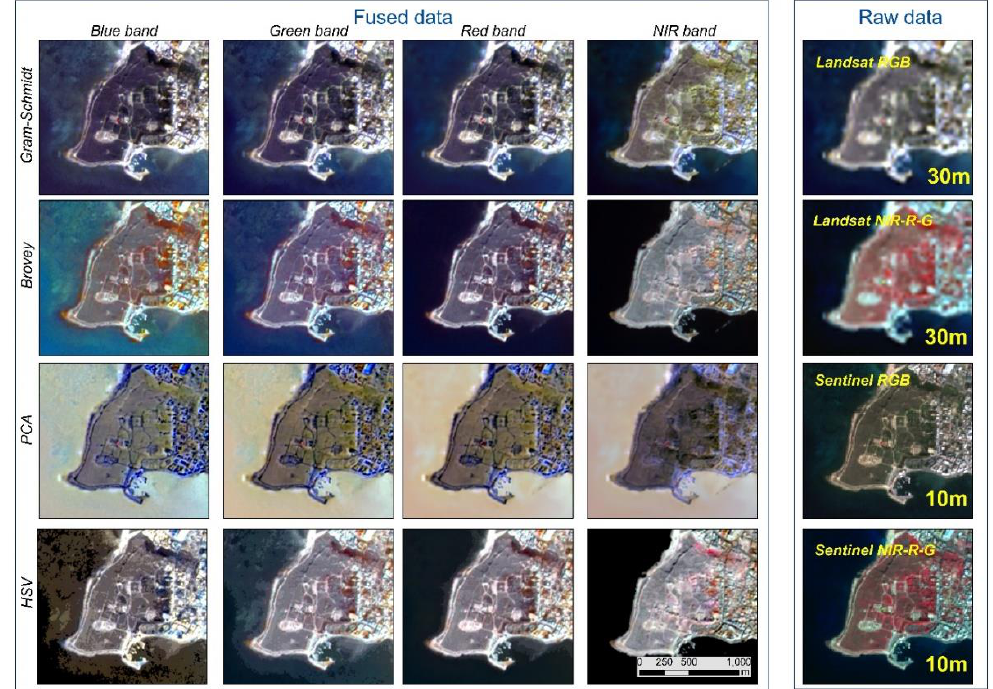
Figure 3. Fusion results of the whole archaeological site of “Nea Paphos” using the four different pansharpening methods (Gram–Schmidt, Brovey, PCA, and HSV, at first to fourth row, respectively) based on the different Sentinel 2 (10 m) spectral bands used as the panchromatic image (columns). The last column indicates the original 30 m Landsat 8 and Sentinel 2 10 m pixel resolution images at the red, green, and blue (RGB), and near-infrared green and blue (NIR-R-G) pseudo composites.